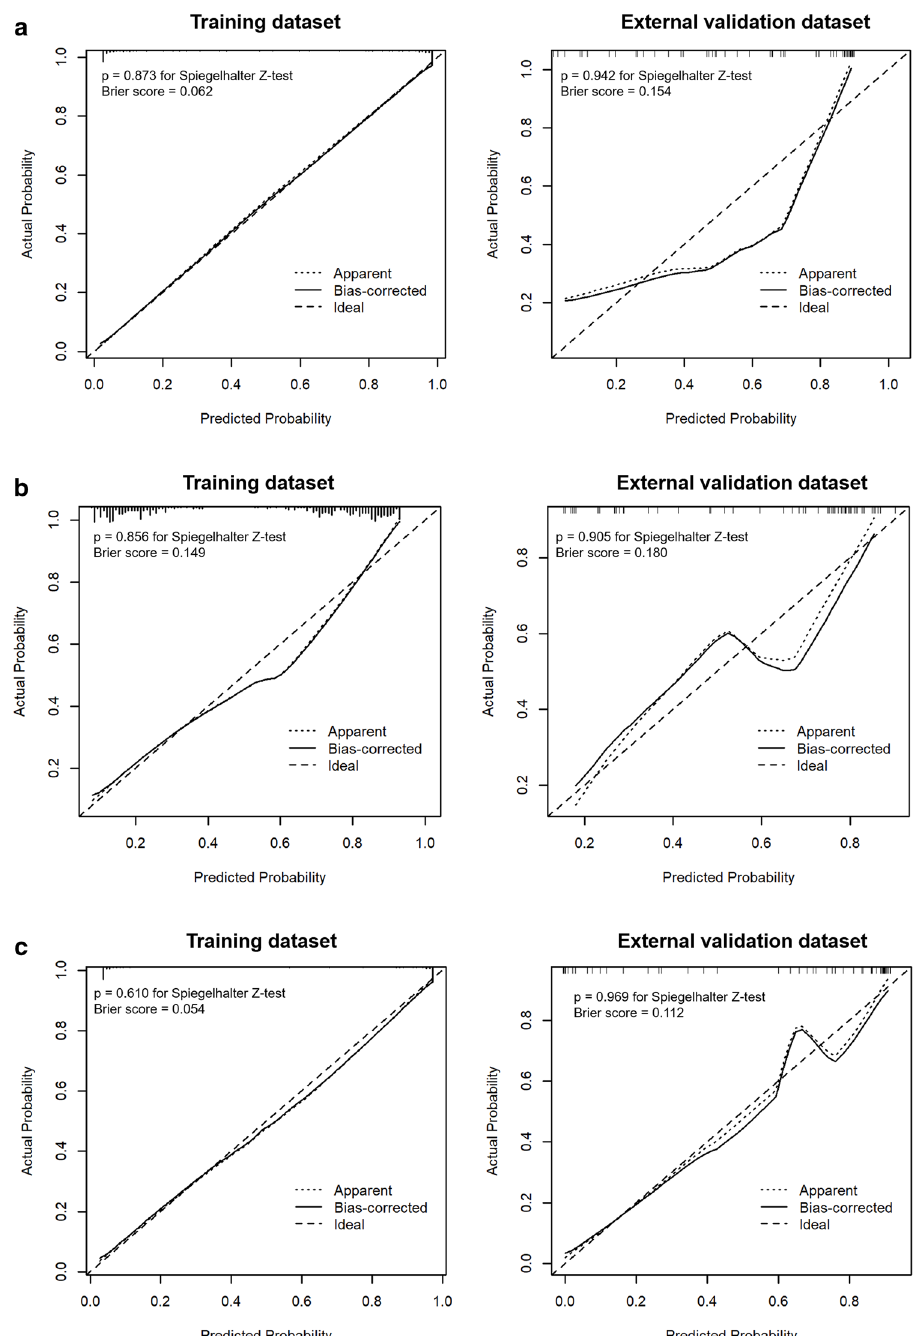
Figure 4. Calibration curves of the different models in the training and validation datasets. ( a ) The radiomics model. ( b ) The clinical model. ( c ) The combined model.